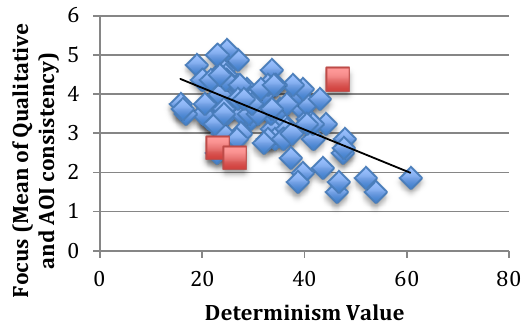
Figure 8 : Mean of the qualitative and quantitative values for attentional focus for the test images used in Farnand (2013) plotted relative to the determinism values. The right-most square point represents the closely-cropped rendition of the Mason Lake scene, which is over-predicted for attentional focus by the determinism value. (The other two squares repre- sent the same images as in Figure